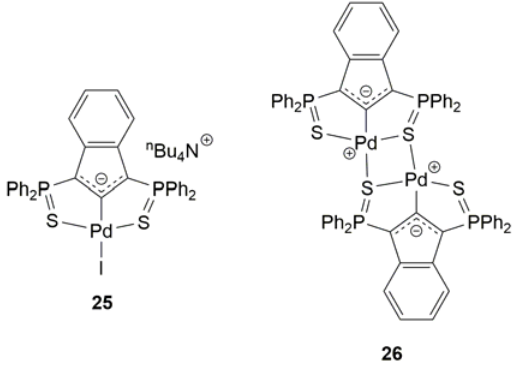
Figure 4. Structure of the palladium(II) pincer complexes 25 and 26 .